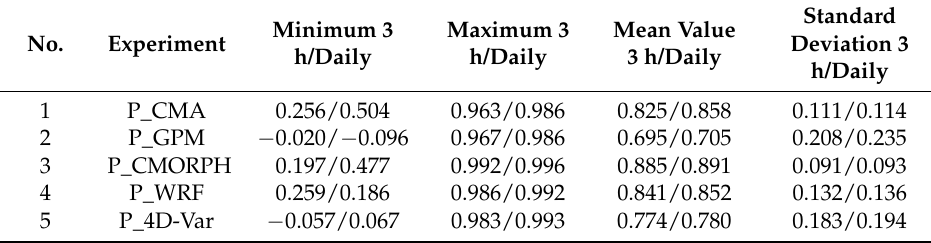
Table 7. Statistics of Pearson’s correlation coefficient between the SMAP soil moisture and the soil moisture simulated by the rainfall-runoff experiments at 3-h and daily time scales.